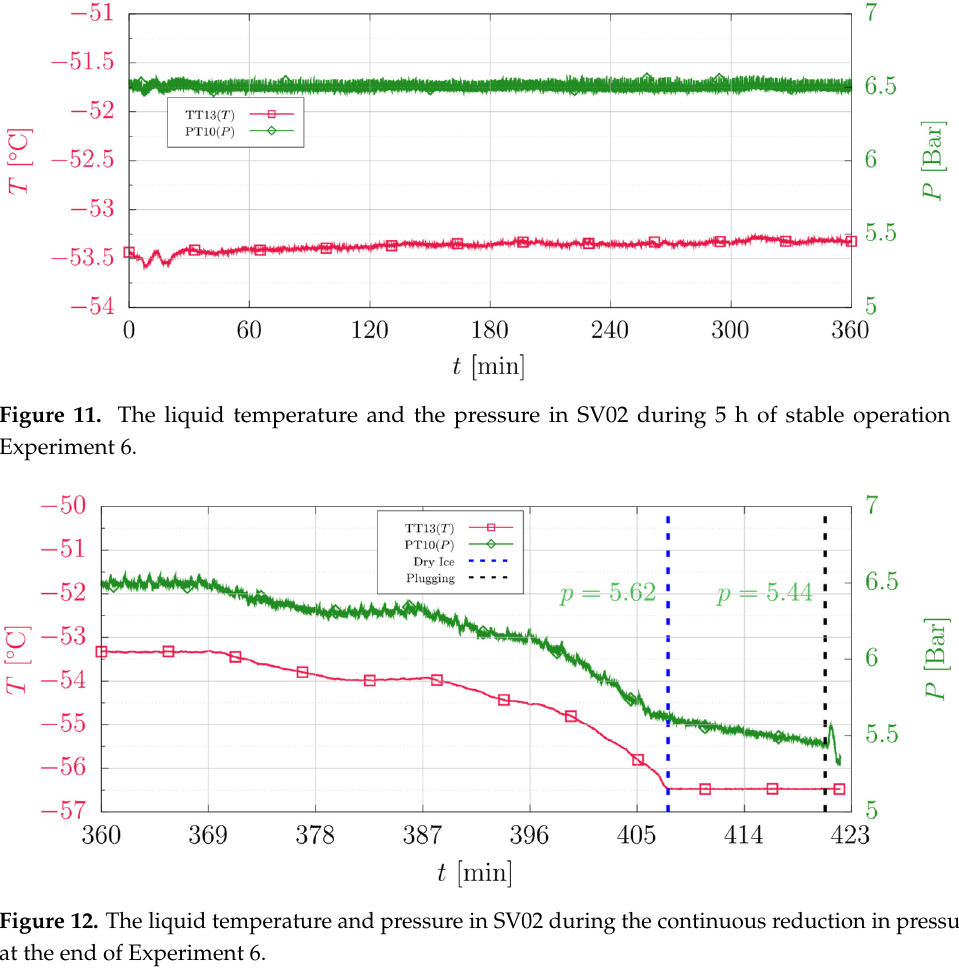
Figure 12. The liquid temperature and pressure in SV02 during the continuous reduction in pressure at the end of Experiment 6. Table 9. Composition of the feed and the gas and liquid outlet of SV01 and SV02 as measured with the GC in Experiment 6.